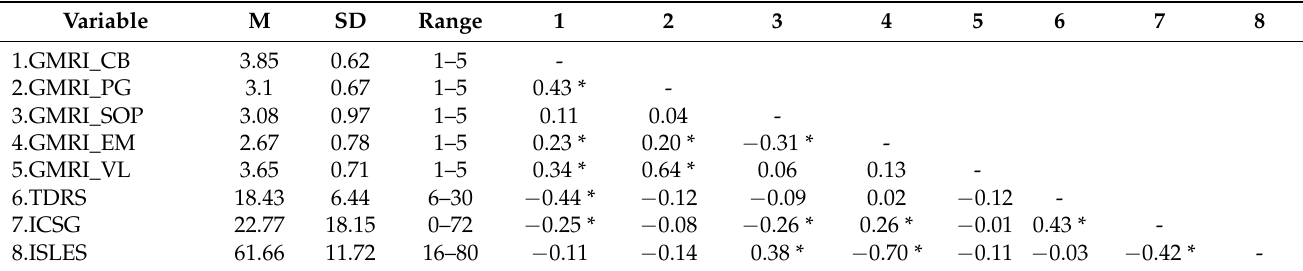
Table 2. Descriptive statistics and bivariate correlations for study variables included in path model ( n = 348).